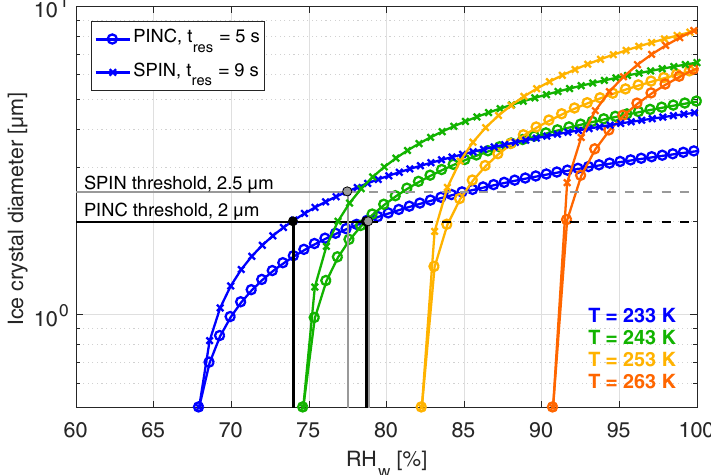
Figure 8. Ice crystal growth calculations for the typical residence times of 5s in PINC (circles) and 9s in SPIN (crosses), according to Rogers and Yau (1989) using a mass accommodation coefficient of 0 . 3. Vertical black lines show the discrepancy in RH w arising from ice crystals counted with the same ice threshold size of 2µm in both SPIN and PINC. Grey lines indicate the ice threshold size used during LINC resulting in a much smaller discrepancy in onset RH w . The ice threshold sizes used for PINC and SPIN are indicated by the horizontal dotted lines. Markers on the line plots are spaced by 1% RH i